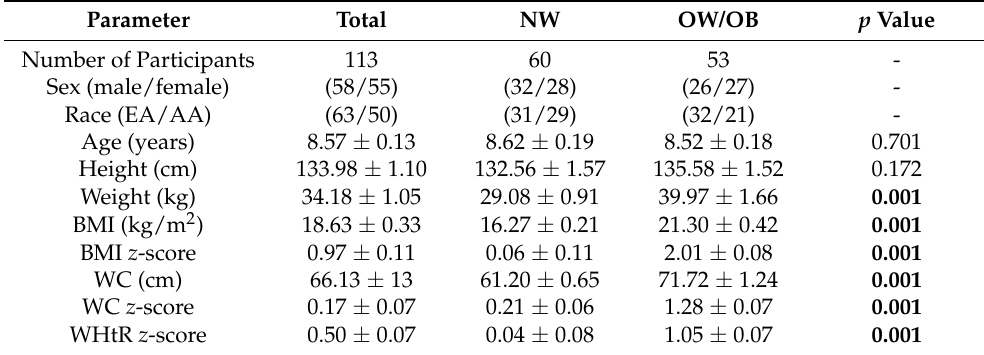
Table 2. General Characteristics of the study population.